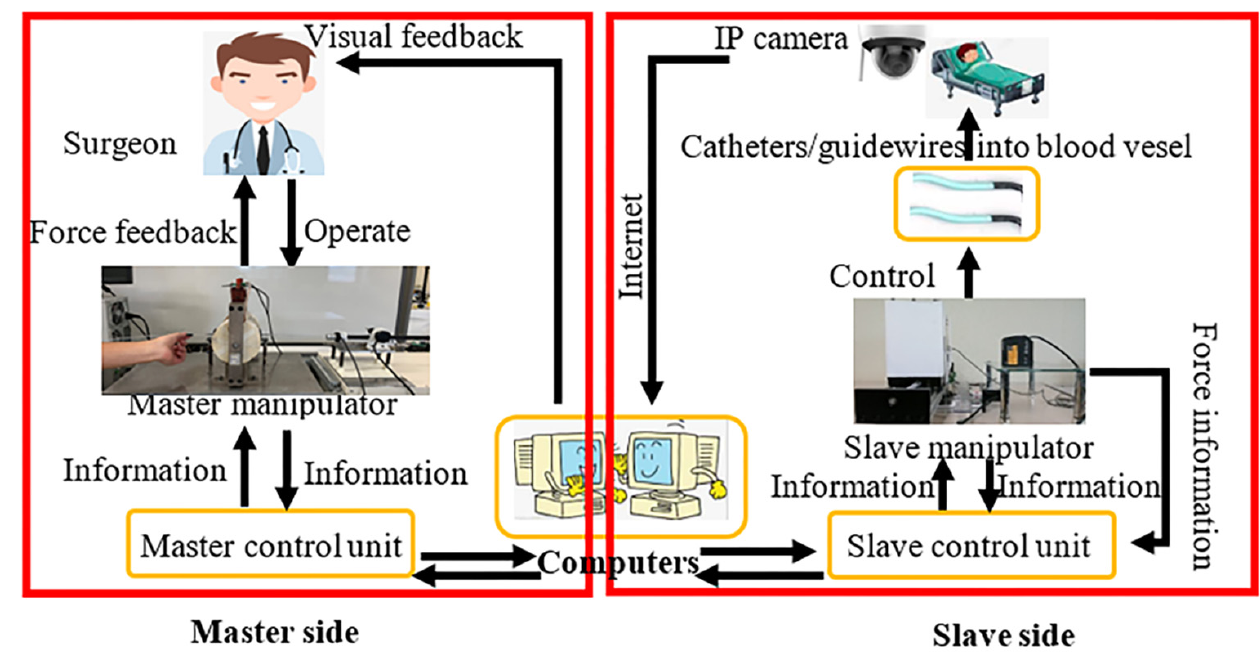
Figure 1. Overview of the master–slave system.